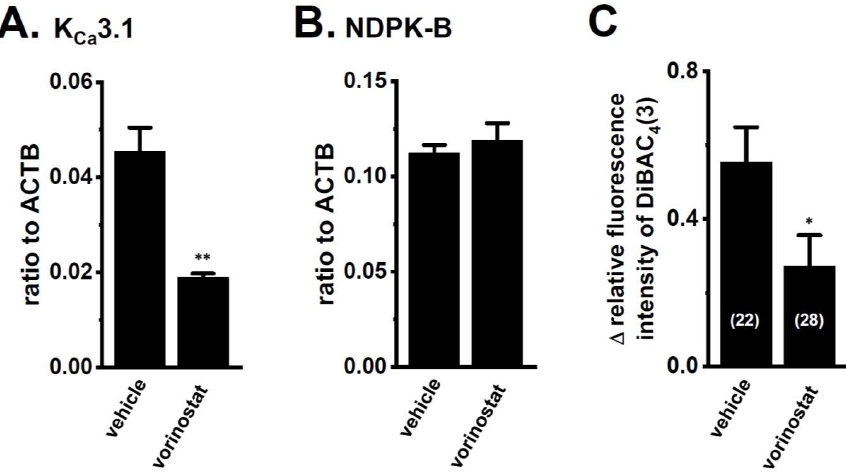
Figure 4. Decrease in the gene expression and activity of K Ca 3.1 by the treatment with 1 μM vorinostat for 24 h in splenic CD4 + T cells of IBD model mice. ( A , B ) Real-time PCR assay for K Ca 3.1 ( A ) and NDPK-B ( B ) in “vehicle”- and “vorinostat”-treated CD4 + T cells ( n = 4 for each). Expression levels were expressed as a ratio to ACTB. ( C ) Summarized data are shown as 1 μM TRAM-34-induced depolarization responses in vehicle- and vorinostat-treated CD4 + T cells. Cells were isolated from three different mice in each group. Cell numbers that were used for the experiments are shown in parentheses. The results are expressed as means ± SEM. *, **: p < 0.05, 0.01 vs. vehicle control.